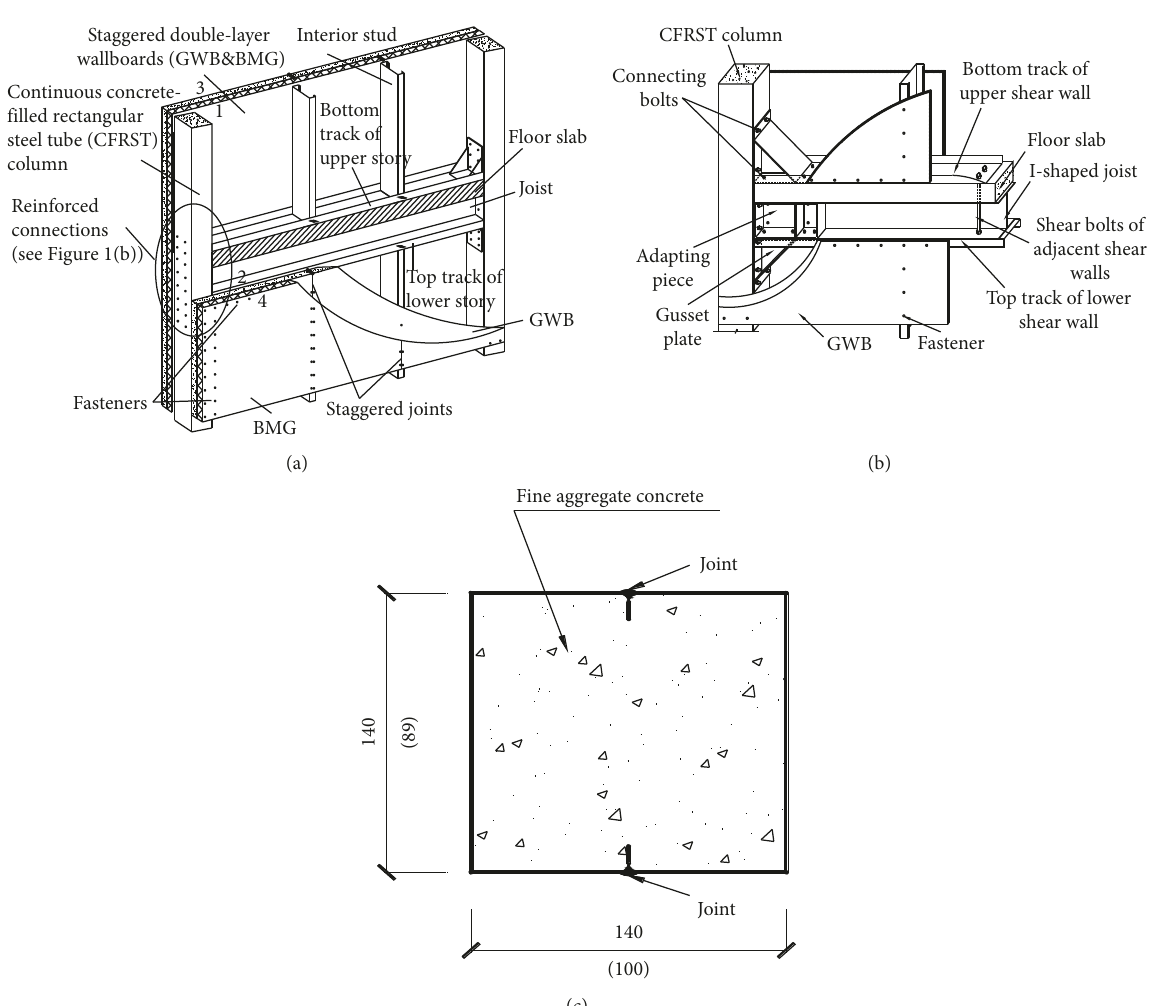
Figure 1: A reinforced cold-formed steel (RCFS) shear wall. (a) Shear wall configurations. (b) Reinforced connection between the CFRST column and top track. (c) Section diagram of the CFRST